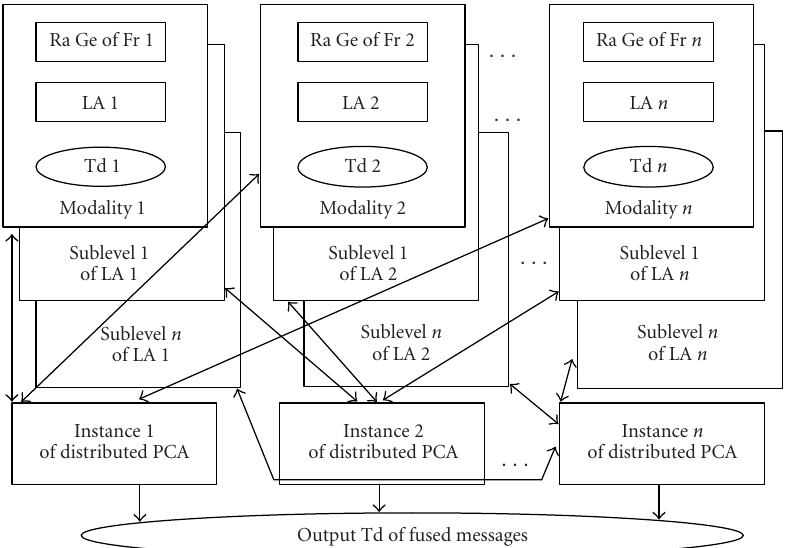
Figure 8: Generic multiagent scaled architecture of the fusion engine for CPN modeling purposes (A: agent, C: control, Fr: fragments of signal, Ge: generator, L: language, P: parallel, Ra: random, and Td: thread). The arrows indicate the information and data flows. features appearing in the proposed generic CPN-modeled ar- chitecture are summarized in four